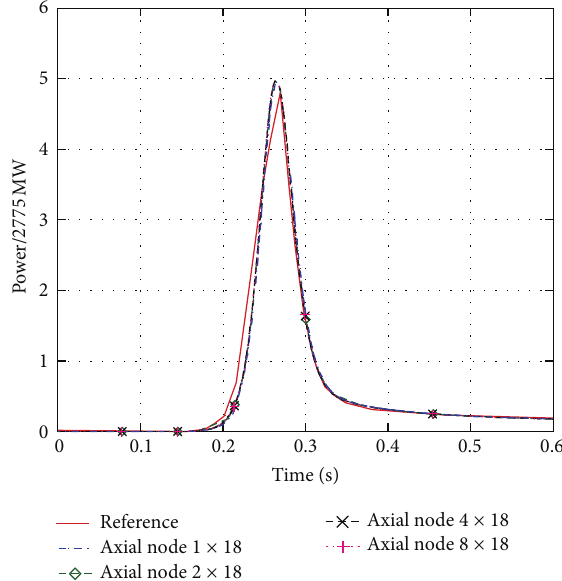
Figure 6: Effect of radial node number per assembly on the maximum fuel centerline temperature for case C2.